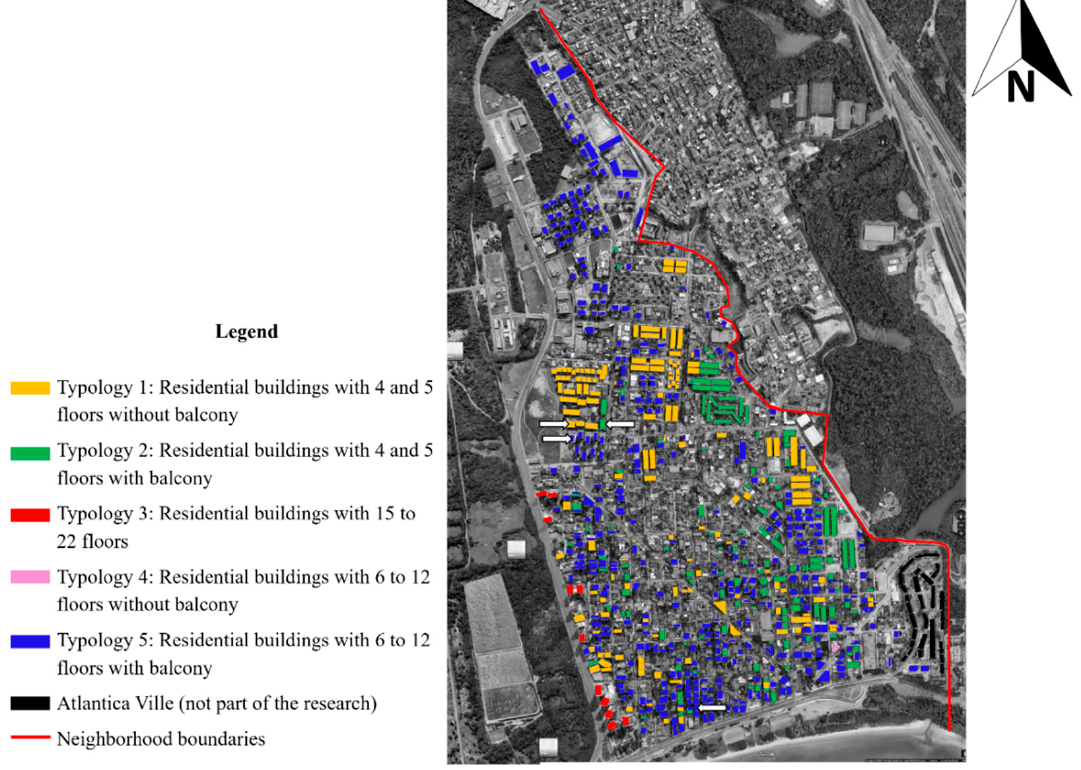
Figure 3. Location of the buildings according to the typologies surveyed in the neighborhood. Appl. Sci. 2019 , 9 , 3832